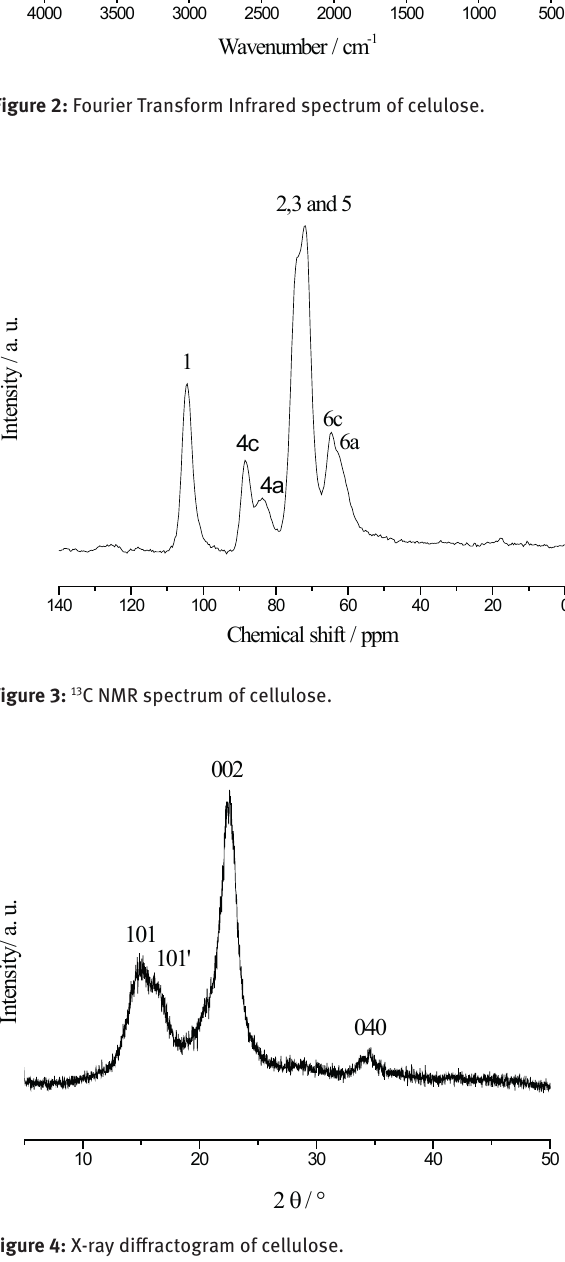
Figure 4: X-ray diffractogram of